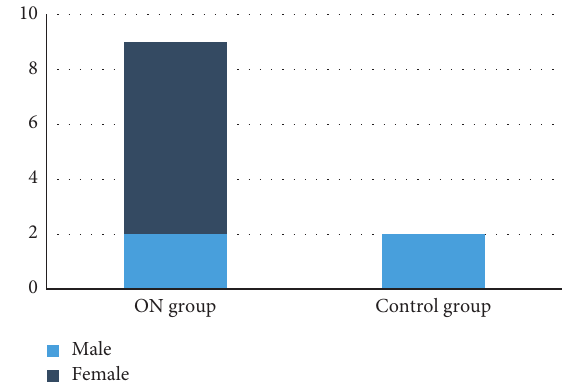
Figure 2: Distribution of high level of serum ACE in both